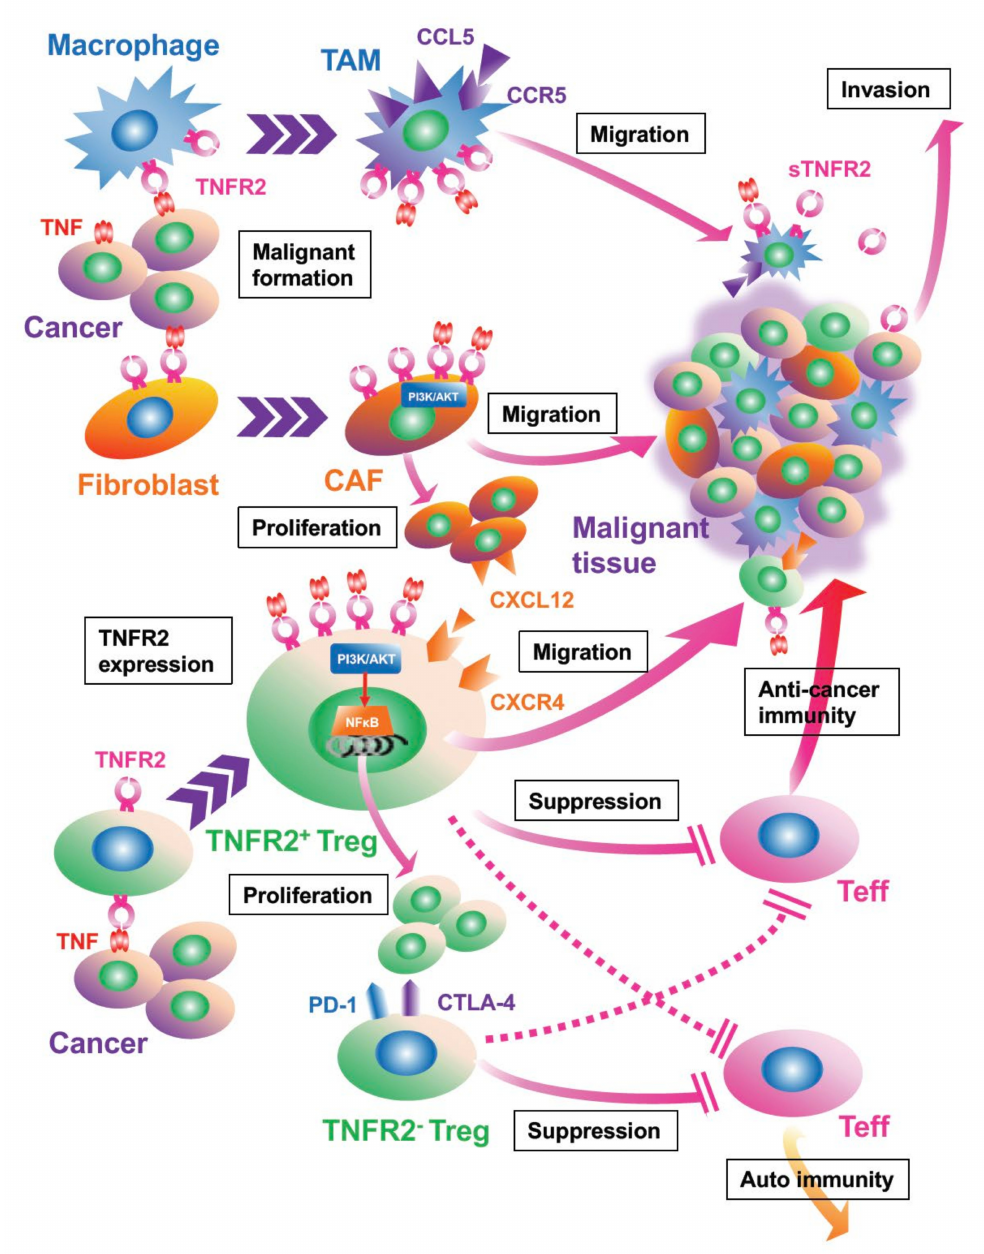
Figure 2. The interaction between cancer cells and stromal cells of the TME via TNFR2 signaling. TNFR2 + macrophages and fibroblasts are influenced by receptor binding of TNF, resulting in a trans- formation to tumor-associated macrophages (TAMs) and cancer-associated fibroblast (CAFs). These cells can accelerate tumor proliferation via phosphatidyl inositol 3 kinase (PI3K)/AKT activation and migration by autocrine or paracrine of chemokine C-C motif ligand 5 (CCL5)/CCR5. Malignant stromal cells are promoters of tumor burden and metastasis through angiogenesis and immunomod- ulation. In addition, sTNFR2 released from TAMs directly drives cancer invasion. TNFR2 + regulatory T cells (Tregs), which are a minor subpopulation in the normal state, accelerate proliferation and migration of malignant tissue via TNFR2 signaling and contribute to tumor growth by strongly sup- pressing effector T cells (Teffs). The degree of TNFR2 expression is associated with the suppressing function, expression of C-X-C motif chemokine receptor 4 (CXCR4), migration of Tregs, and predicts the prognosis of patients with malignant disease. Meanwhile, TNFR2 - Tregs, which usually express programmed cell death protein 1 (PD-1) and cytotoxic T lymphocytes-associated protein 4 (CTLA-4), are considered to play a critical role in immunomodulation in the normal